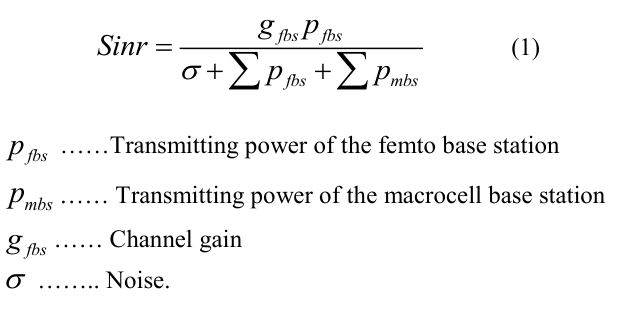
Table 1: Femtocell and other cellular networks Table column